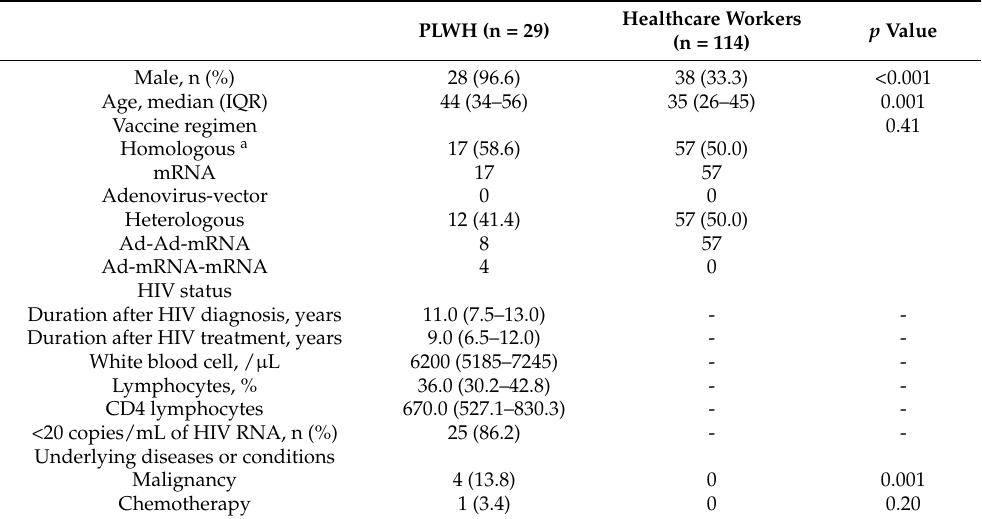
Table 1. Clinical characteristics of third dose vaccinated patients living with HIV and healthcare